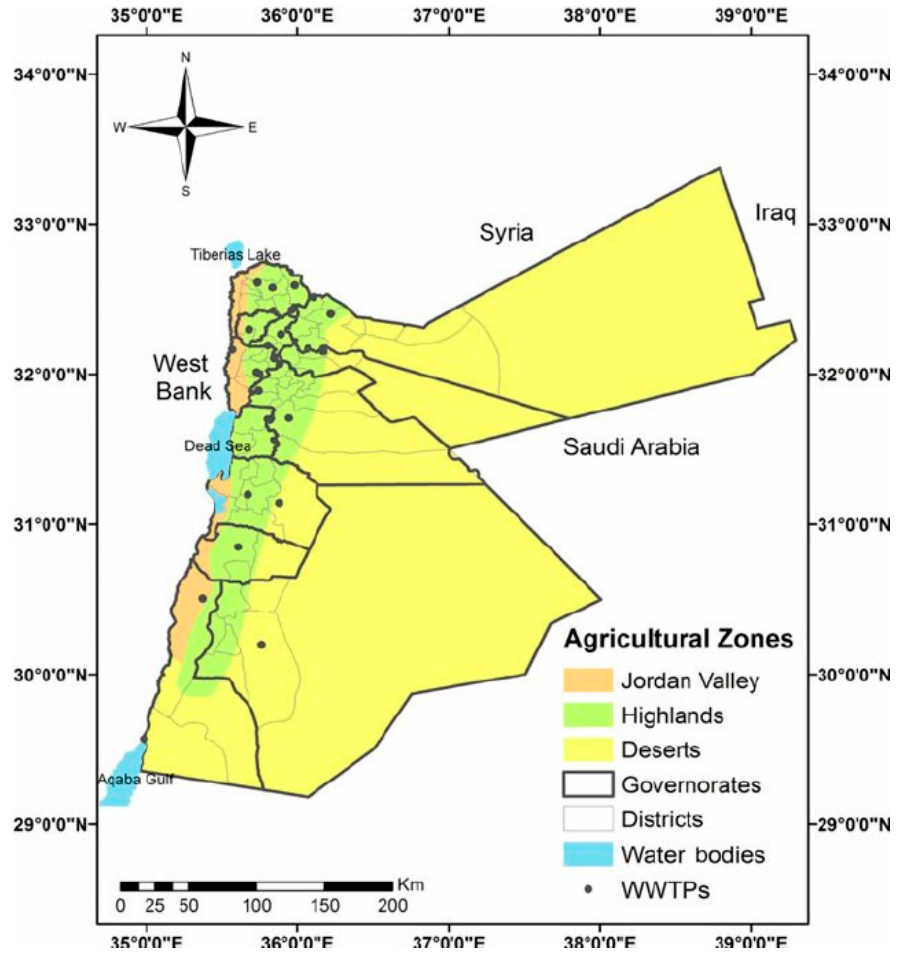
Figure 1. Map of the Jordanian desert, Badia, and agricultural zones.